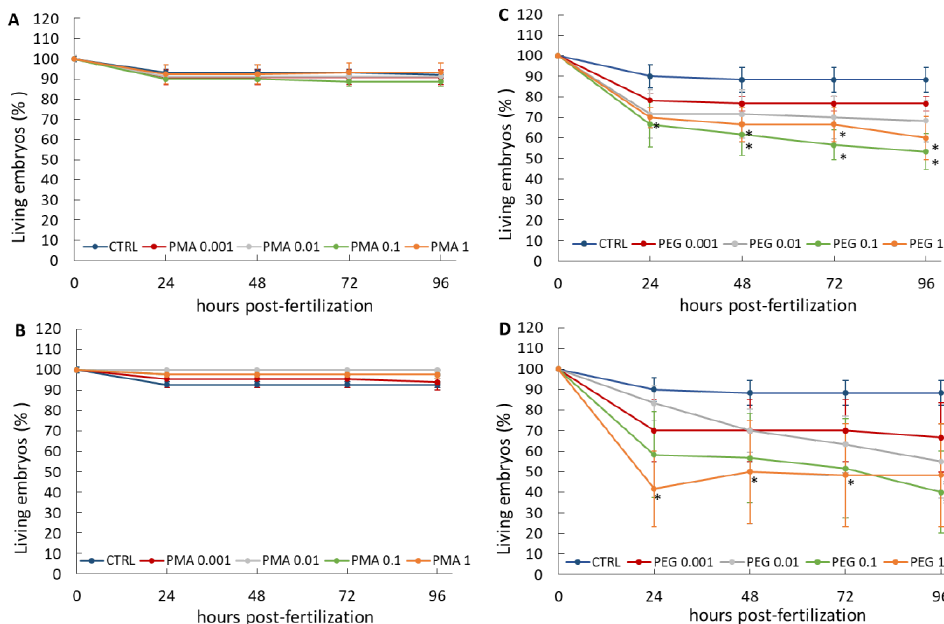
Figure 3. Viability (%) of zebrafish embryos exposed or not (control (CTRL)) to 0.001–1 nM GNP@PMA 6 nm ( A ) or 15 nm ( B ), or GNP@PEG 6 nm ( C ) or 15 nm ( D ). Mean ± standard error (SE) of three different experiments. * p < 0.05 vs. the corresponding CTRL (one-tailed t -Student